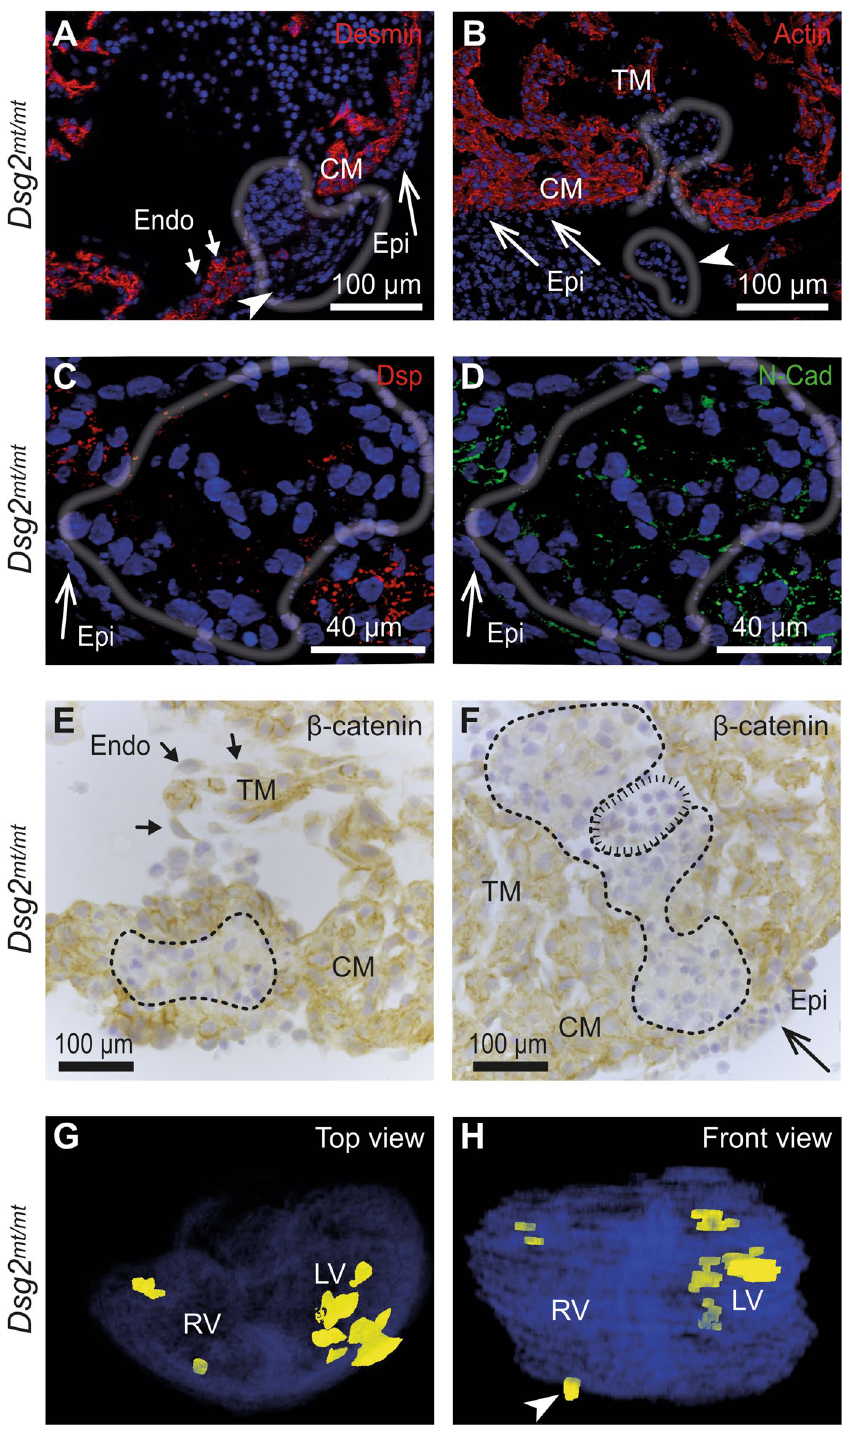
Figure 3. Abnormal cell clusters are for the most part negative for cardiomyocyte markers. ( A , B ) The E11.5 Dsg2 mt/mt heart sections are stained with anti-desmin or anti-fetal cardiac actin antibodies revealing strictly demarcated negative cell clusters (gray contour lines). Note the large number of nuclei in the pericardial cavity (arrowheads) and the extrusion of a compact cell cluster (arrowhead and delineated by gray contour line in B ). CM, compact myocardium; Epi, epicardium (long arrows); Endo, endocardium (short arrows). ( C – F ) show immunohistological micrographs of Dsg2 mt/mt heart sections containing cell clusters that express little or no desmoplakin (Dsp), present reduced N-cadherin (N-Cad) and are negative for β-catenin. Contour lines delineate the entire cell clusters in the consecutive sections in ( C , D ), dashed lines demarcate type A clusters in ( E , F ) and the striated line in ( F ) encircles a small type B cell cluster. TM, trabecular myocardium; ( G , H ) Top and front views of a 3D reconstruction prepared from 40 serial hematoxylin/eosin-stained sections of an E11.5 Dsg2 mt/mt heart. The abnormal cell clusters are colored in yellow and ventricular myocardium in blue. RV, right ventricle; LV, left ventricle. The white arrowhead points to a cluster of cells that is released into the pericardial cavity. Data are representative images of n = 5–6 hearts per group and analysis. Size bars: 100 μm in ( A , B , E , F ) and 40 μm in ( C , D